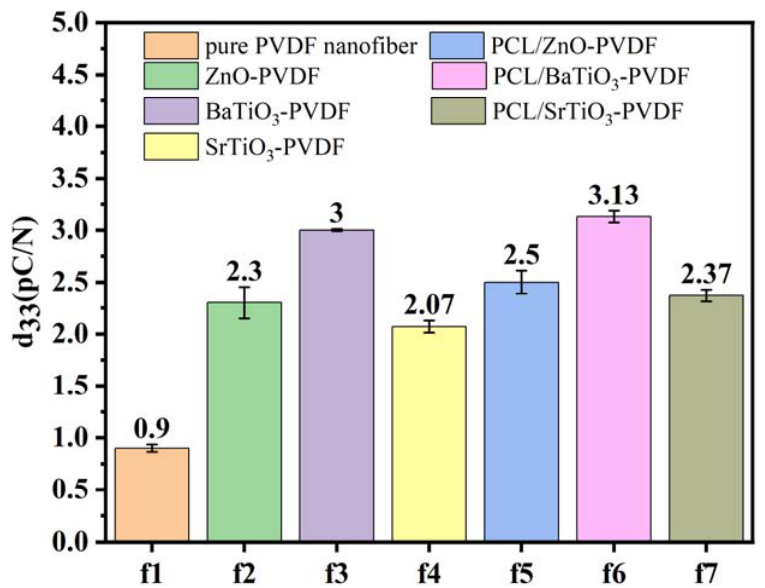
Figure 7. The d 33 piezoelectric coe ffi cient of electrospinning fi bers.